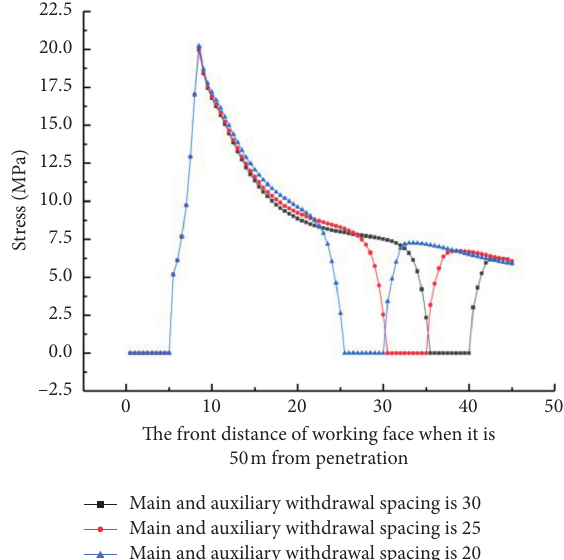
Figure 20: Vertical stress curve when Panel 31113 is penetrated.